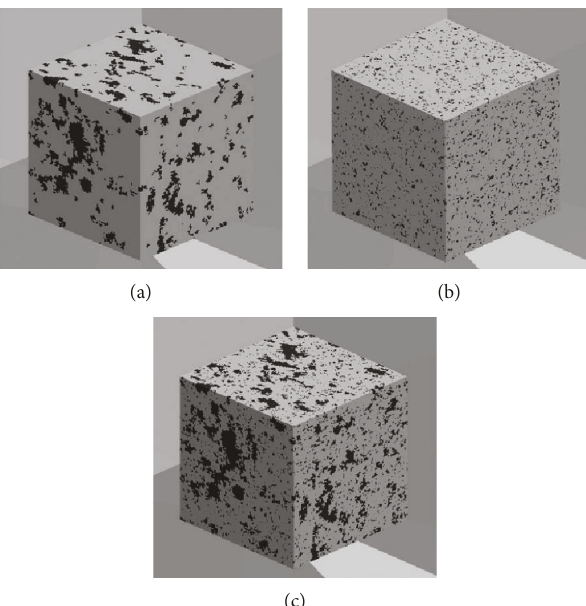
Figure 16: Shale 3D digital cores reconstructed using multiscale reconstruction method. Among them, the grey part is the skeleton, and the black part is the pores. (a) Shows an inorganic pore digital core, (b) shows an organic pore digital core, and (c) shows a nested digital core. Figure from [153].